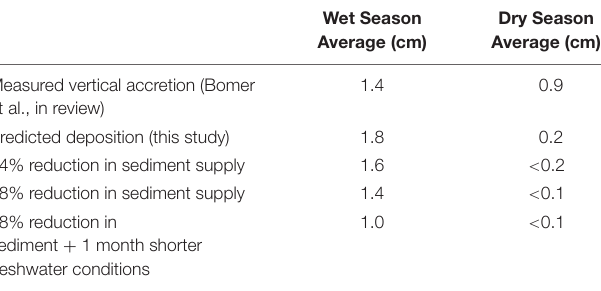
TABLE 2 | Predicted change in seasonal deposition according to the projected changes in suspended sediment supply and fresh water due to the IRLP, as described by Higgins et al.